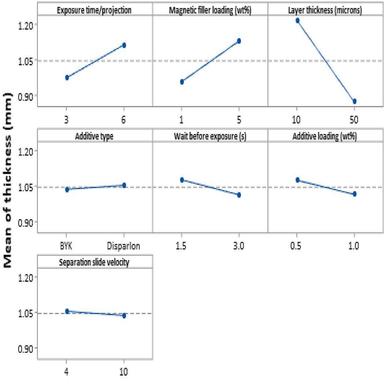
Main effects plot representing mean of measured thickness.